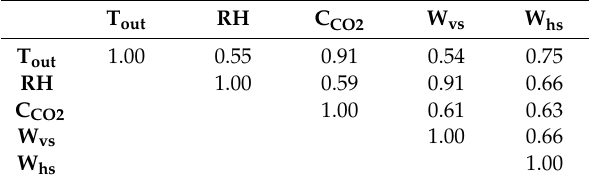
Table 3. Pearson coe ffi cient (R 2 ) betwewn environmental and energy